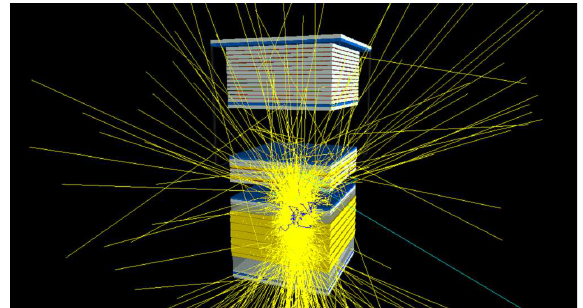
Figure 2. The interaction of the 100-GeV gamma ray with the GAMMA-400 matter with the formation of backscattering parti- cles. Secondary gammas, positrons and electrons are marked by yellow, violet and blue colors respectively